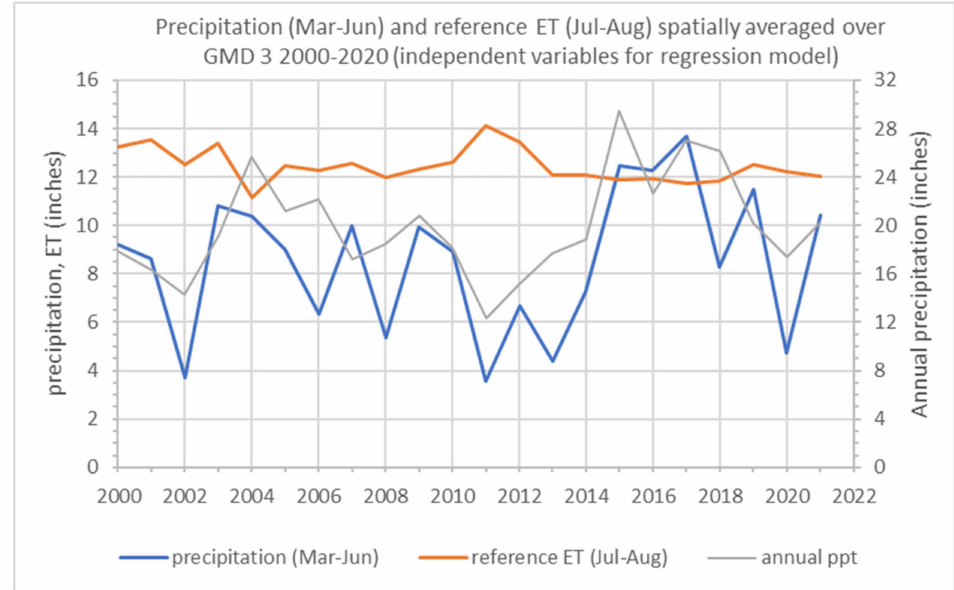
Figure A2. Predictive climatological variables used to estimate pumping for GMD 3 2000–2020 are reference ET (Jul–Aug, blue) and precipitation (Mar–June, orange), both plotted against the left axis. Annual precipitation, plotted against the righthand axis, is shown for